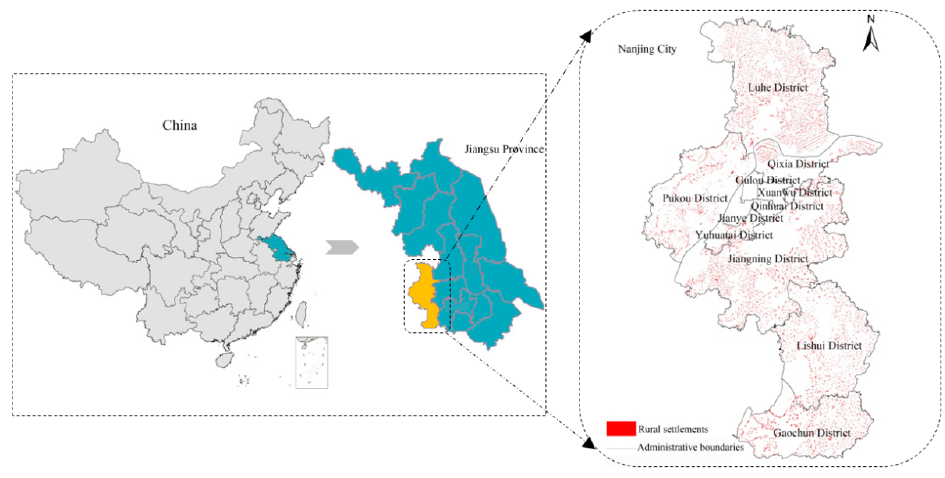
Figure 2. Location map of Nanjing.